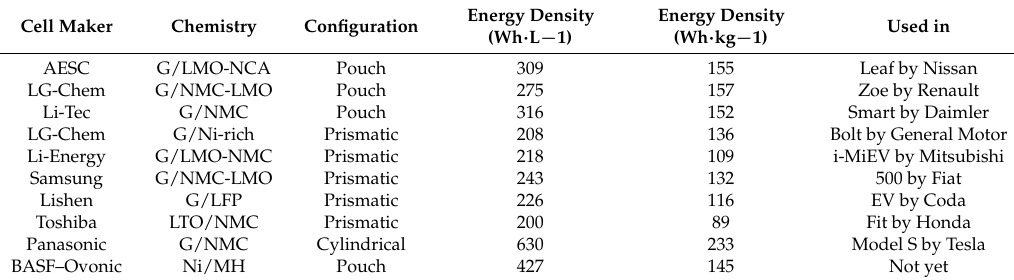
Table 1. Gravimetric and volumetric energy densities of several batteries used in electric vehicle (EVs). G and LTO are graphite and Li-titanate anodes for Li-ion batteries, respectively. LMO, NCA, NMC, and LFP are Li-spinel, LiNiCoAl oxide, LiNiMnCo oxide, and LiFePO 4 cathodes for Li-ion batteries, respectively.